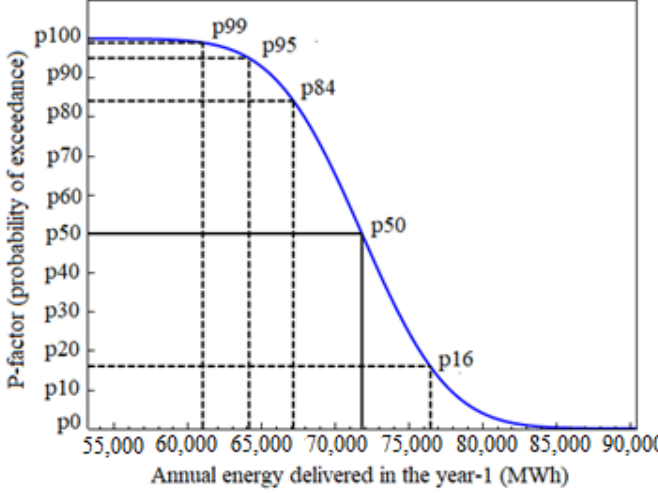
Figure 15. System’s P 16 , P 50 , P 84 , P 95 , P 99 probability of annual energy production (layout 1).